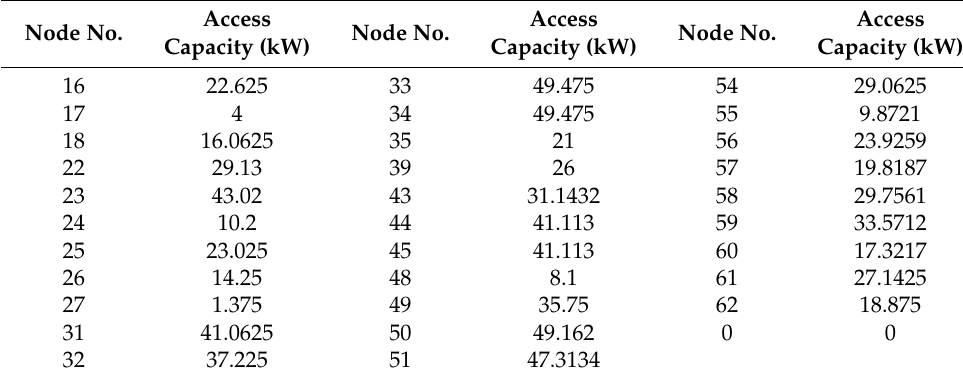
Table 4. DG actual locating and sizing scheme.